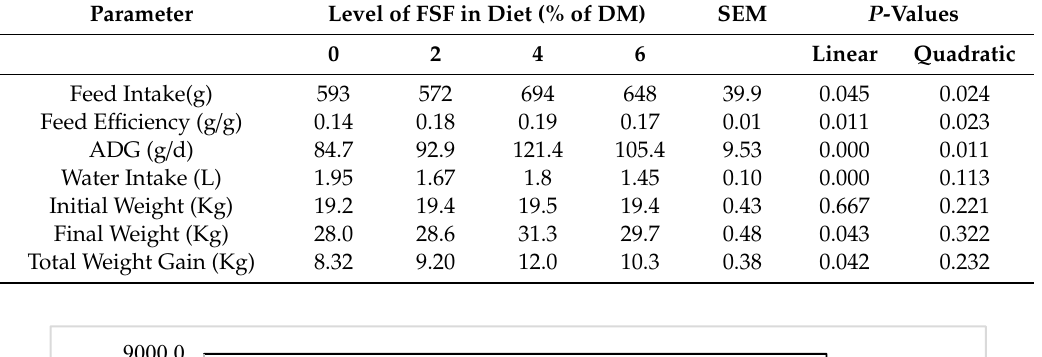
Table 2. Effects of varying levels of FSF on growth performance and water intake on Dohne-Merino wethers.